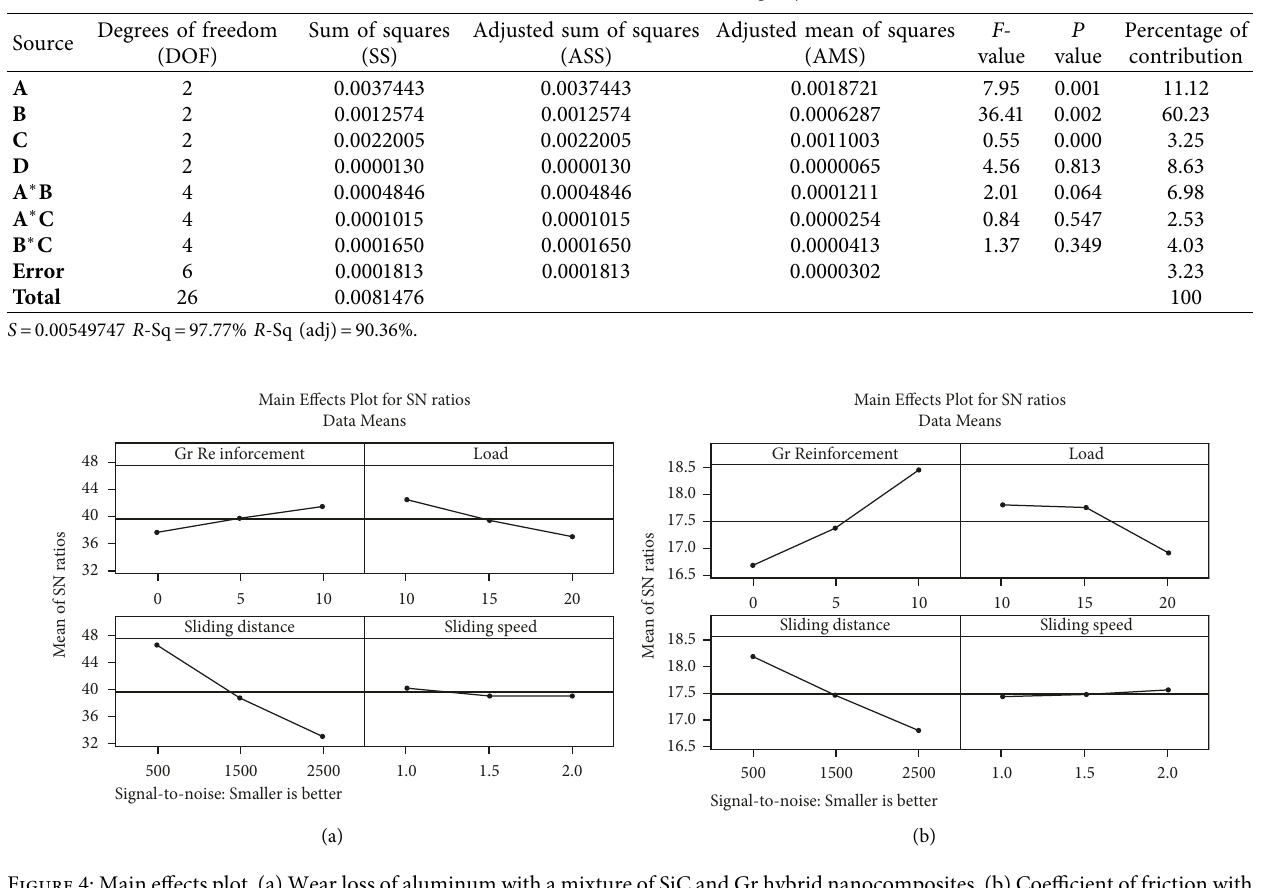
Table 7: ANOVA for the friction coefficient, using adjusted SS for tests.